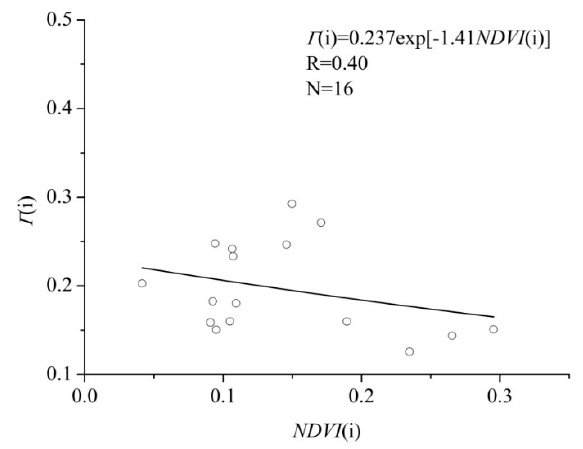
Figure A1. The fitting curve between the coefficient Γ (i) of the linear relationship between G 0 to R n and the corresponding NDVI (i)